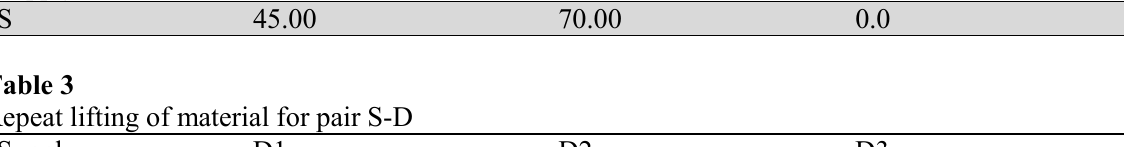
Coordinate of supply locations Supply